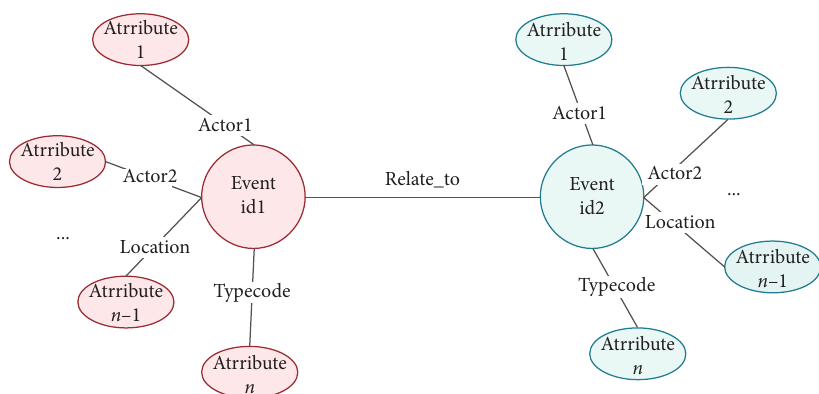
Figure 5: Schematic diagram of the event element association